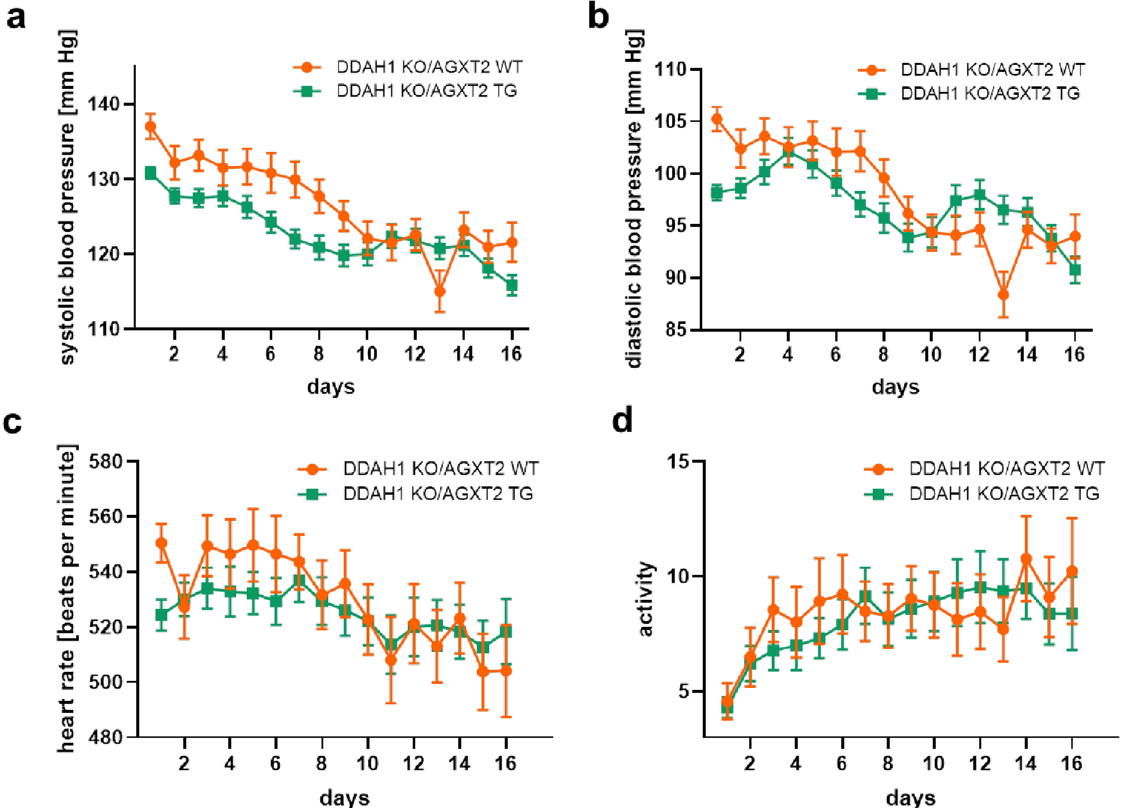
Figure 7. Systolic ( a ) and diastolic ( b ) blood pressure, heart rate ( c ) and activity ( d ) in DDAH1 KO/AGXT2 WT and DDAH1 KO/AGXT2 TG mice. Repeated-measures ANOVA followed by Sidak multiple comparison test. N =